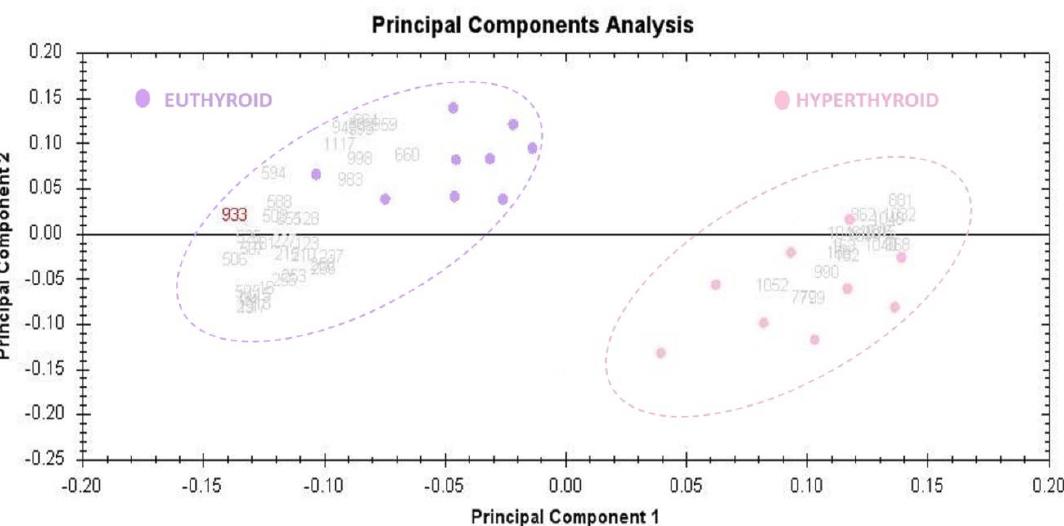
Figure 3. The Progenesis SameSpots software was used to assess and visualize the samples of hyperthyroid and euthyroid subjects using the principal component analysis (PCA). All 40 spots with statistically significant (ANOVA, p < 0.05) changes in abundance determined by MS were subjected to PCA. The tests showed that the two groups clustered differently based on different proteins, with a significant score of 62 percent.